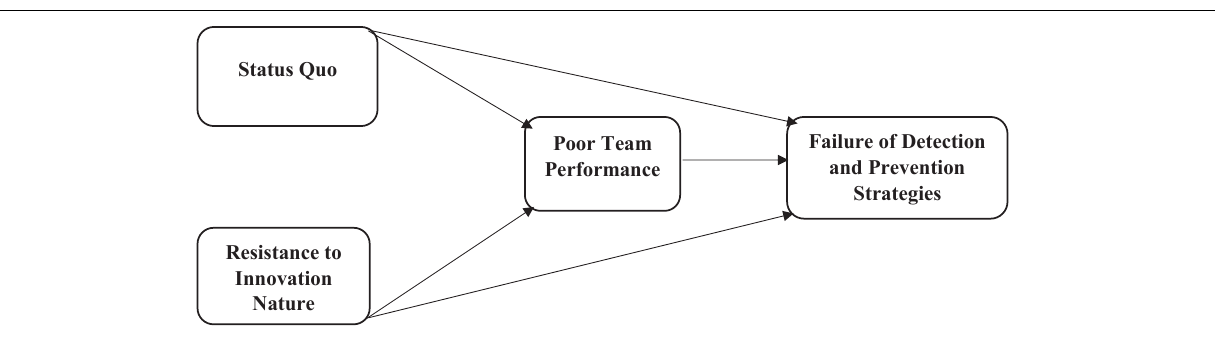
FIGURE 2 | Theoretical